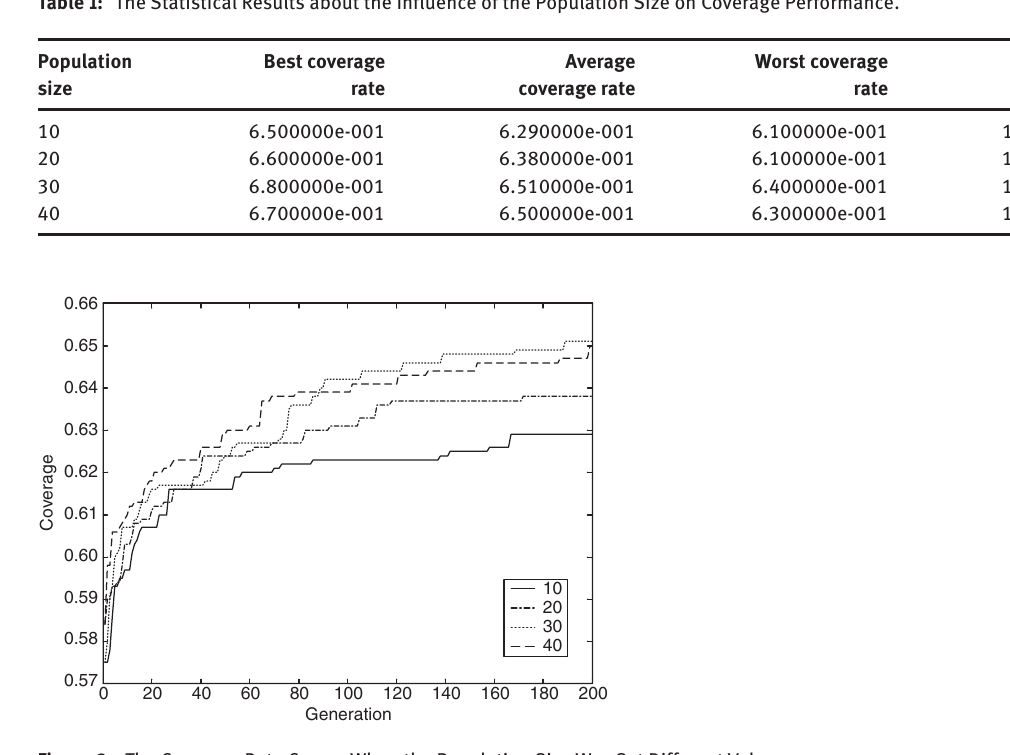
Figure 2: The Coverage Rate Curves When the Population Size Was Set Different Values.